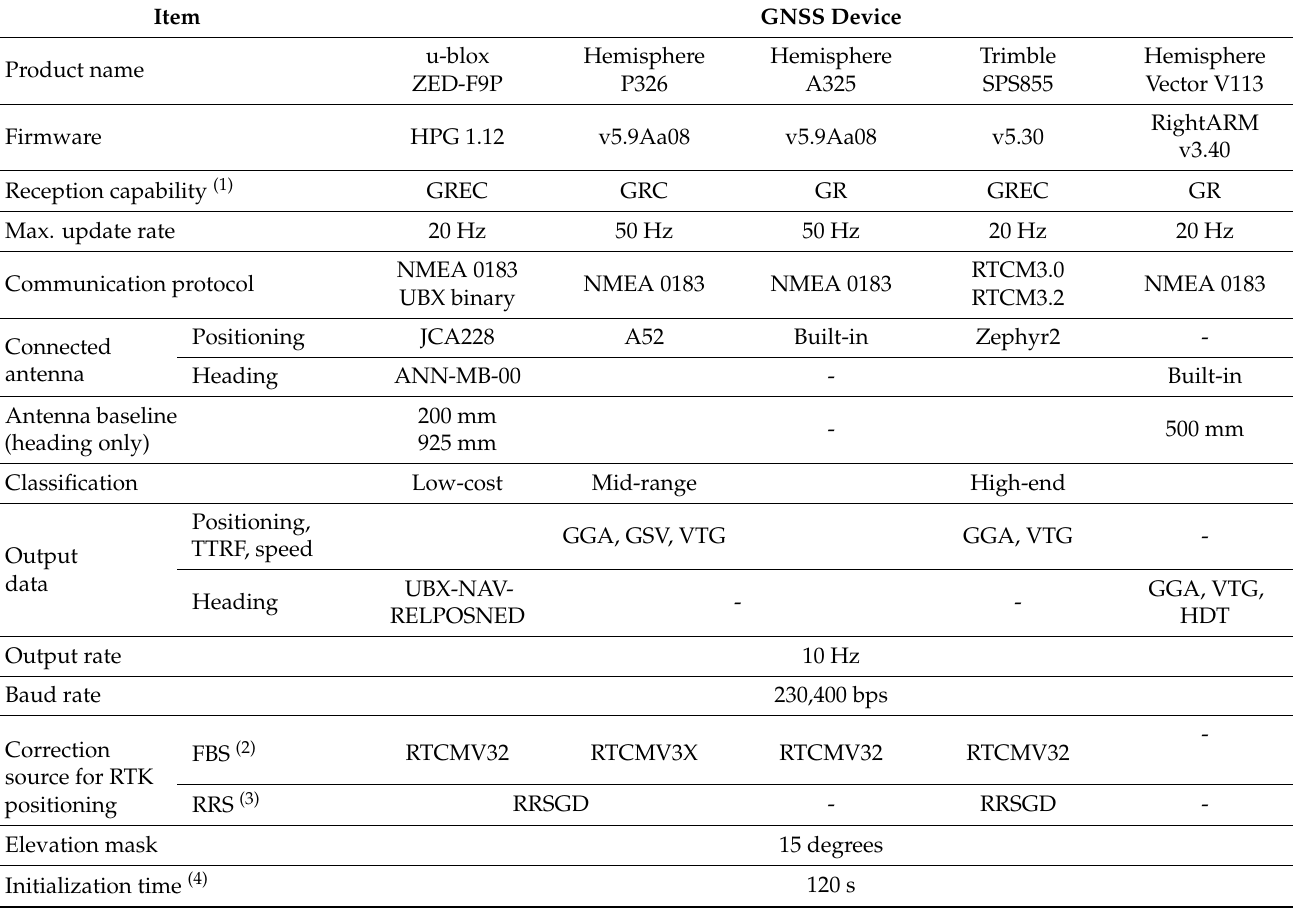
Table 1. Main specifications and settings of GNSS receivers used in the dynamic